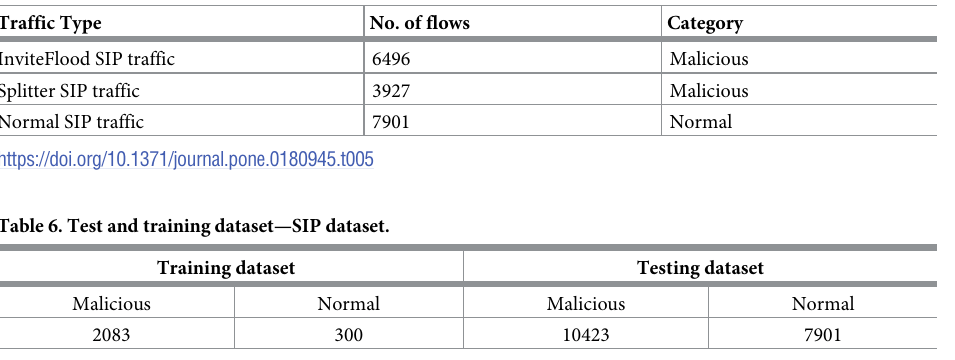
Table 5. Detail of flow records—SIP dataset.